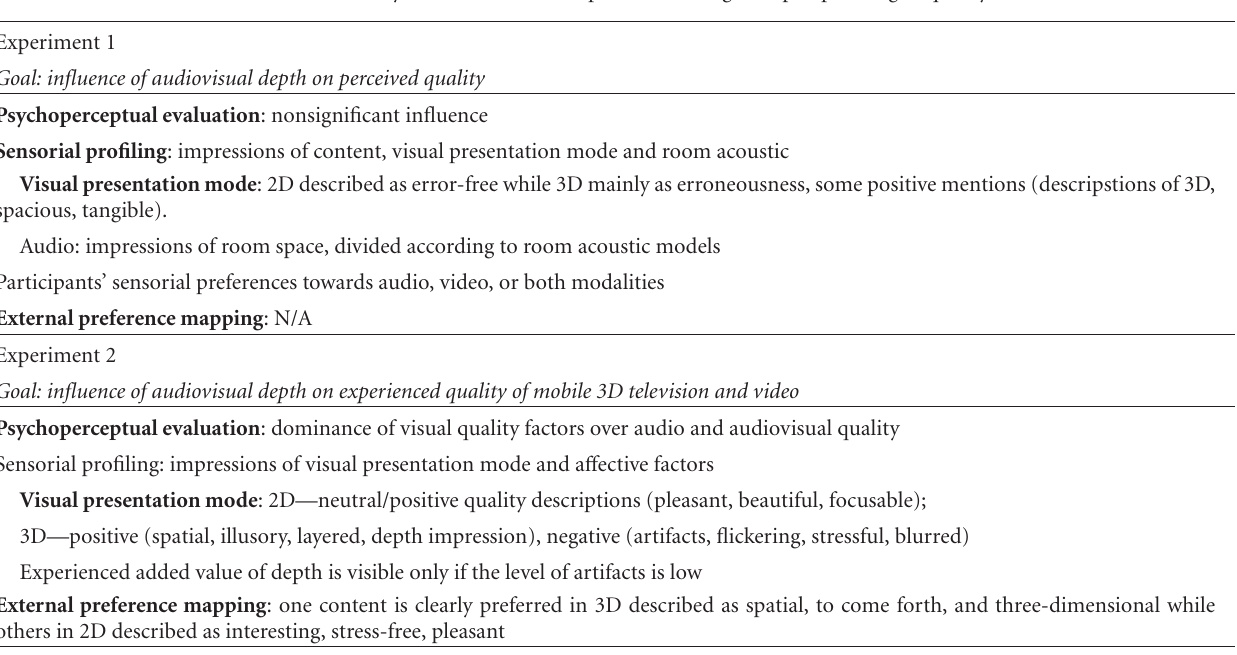
Table 8: Summary of results of three experiments using the open profiling of